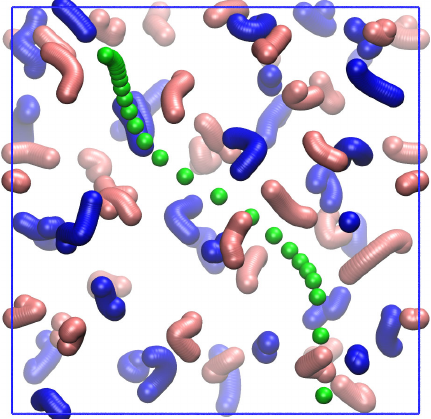
FIG. 5. Overlay of several consecutive snapshots from a 435 fs- long sample of AIMD trajectory of our K 33 Cl 31 model. K þ ions are depicted in pink and Cl − ions in blue, while the Wannier center associated to the lone bipolaronic pair is displayed in green.